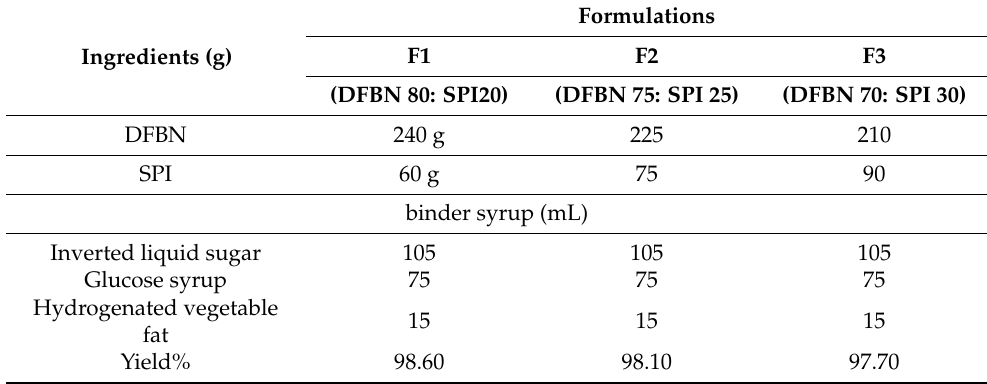
Table 1. Bar formulations made with Defatted Flour of Brazil Nuts (DFBN) and Soy Protein Isolate (SPI).